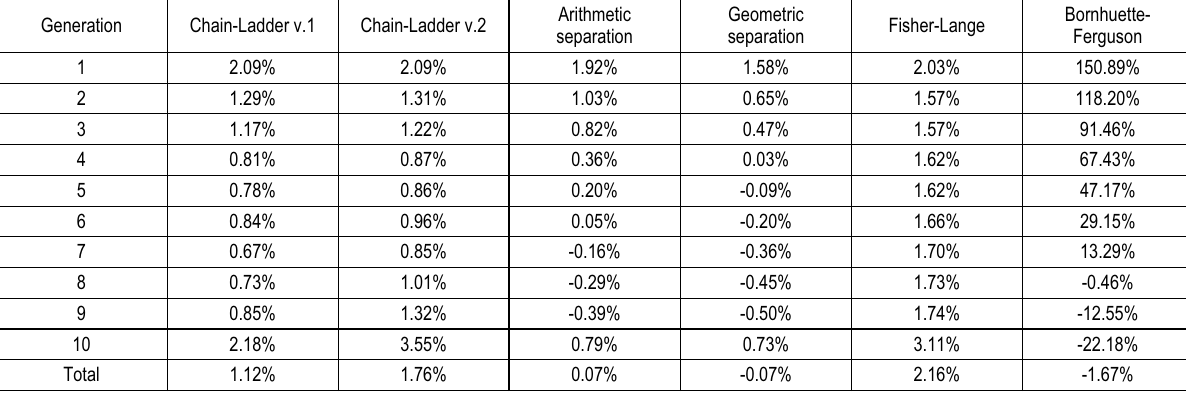
Table 16. Mean percentage error Pentikainen-Rantala